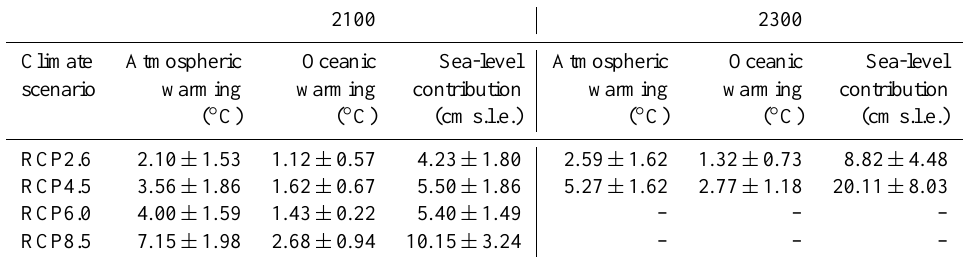
Table 4. Ice-sheet-wide mean atmospheric warming, basin-mean oceanic warming, and ensemble-average contribution of the Greenland ice sheet to global sea-level change by 2100 and 2300. Sea-level changes are calculated with respect to the year 2000. Ensemble averages for each scenario use equal weights for individual AOGCMs. The root mean square deviation from the mean ensemble realisation is added to estimate the